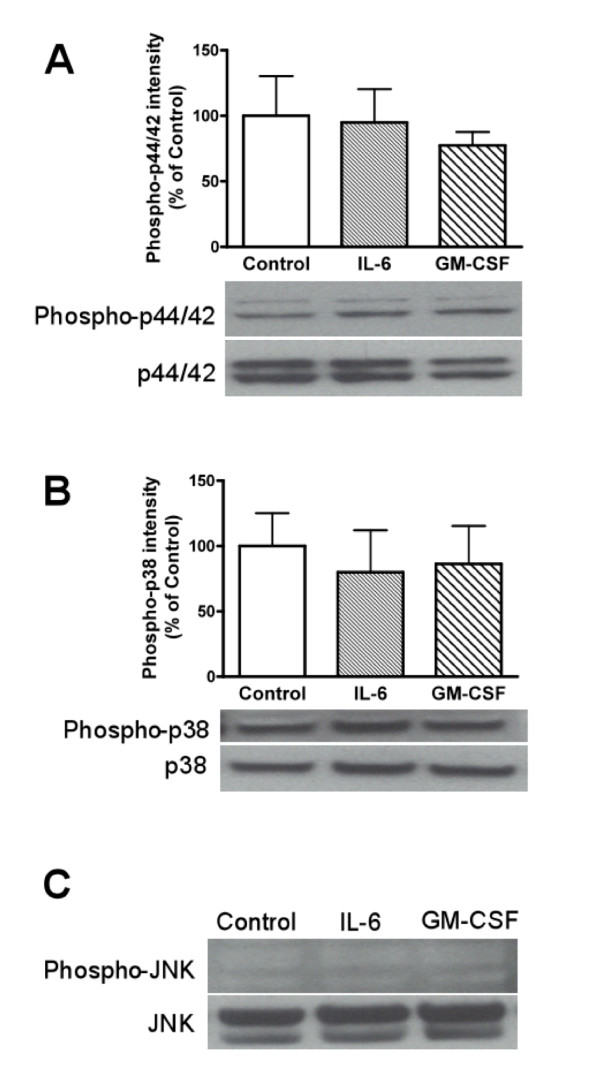
Effects of IL-6 and GM-CSF on phosphorylation of MAPKs in BMECs. BMECs were exposed to IL-6 (100 ng/mL) or GM-CSF (100 ng/mL) for 4 hr. Western blot analyses were performed to detect phosphorylated p44/42 MAPK (A), p38 MAPK (B), and JNK (C) as well as total p44/42 MAPK, p38 MAPK, and JNK. Relative intensity is calculated as ratio of arbitrary densitometric units of phoshorylated protein to that of total protein. (C) For phospho-JNK, sorbitol-treated PC12 cells were used as positive control (data not shown). Results are expressed % of control. Values are means ± SEM (n = 3-4). Photographs are representative in three to four independent experiments.